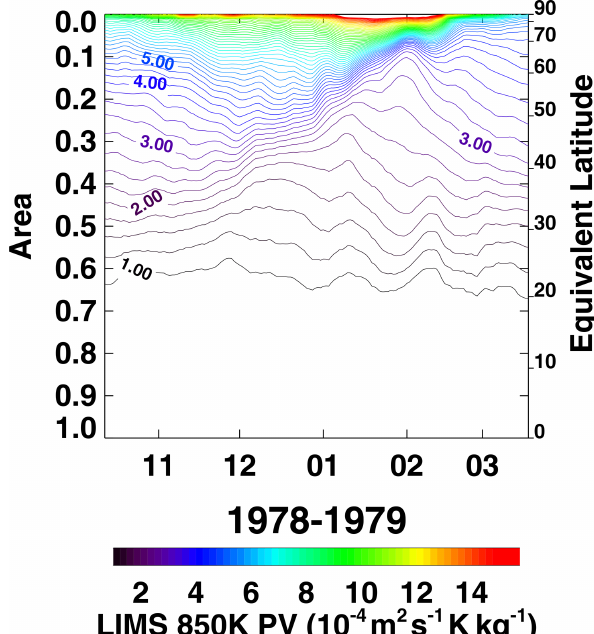
Figure 16. Area diagnostic plot of time series of NH potential vor- ticity (PV) contours on the 850K potential temperature surface for comparison with Butchart and Remsberg (1986, their Fig. 4). PV comes from LIMS V6 level 3 geopotential height and tempera- ture data. Contour interval (CI) is 0.25PV units (units of PV are 10 − 4 m 2 s − 1 Kkg − 1 ). Tick marks on the abscissa denote the 15th day of each